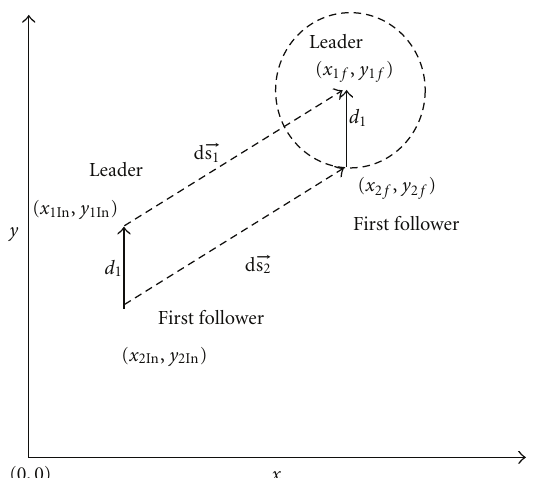
Figure 3: Motion of leader and first follower for a very small duration of time.